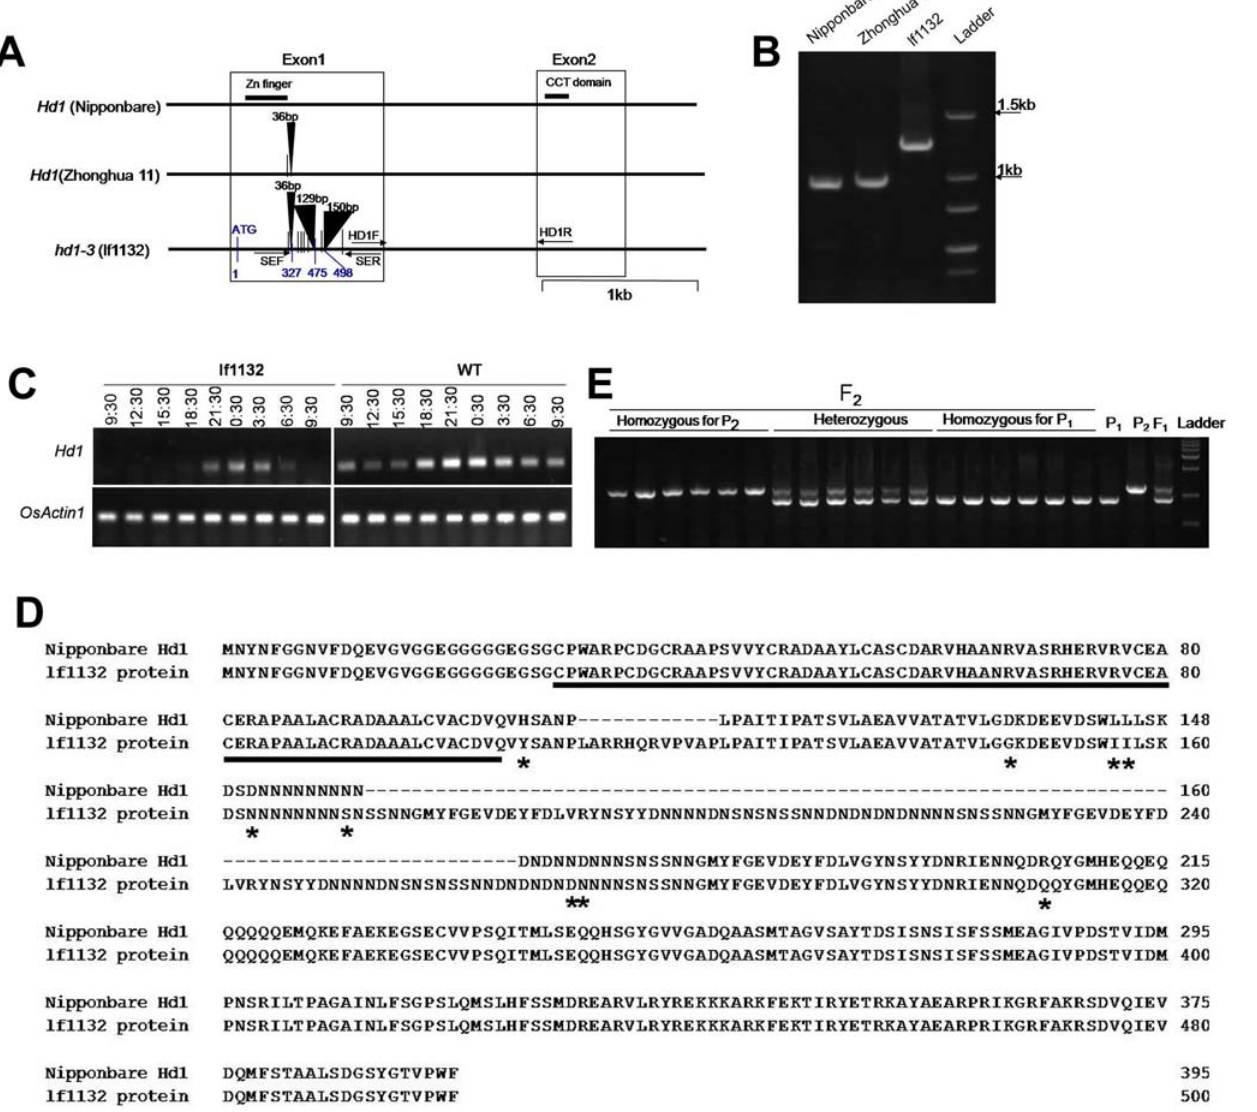
Figure 3. Sequence analysis of Hd1 in lf1132 and wild type. A: The sequence differences between wild type and lf1132 . The black triangle represents insertion; vertical lines represent single-base substitutions; blue vertical lines and numbers are relative positions in hd1-3 . SEF and SER shown by arrows are primers to detect the 315 bp insertion. B: PCR detection of the 315 bp insertion on the hd1-3 locus for lf1132 . C: The expression of Hd1 in the wild type and mutant. Leaves were harvested from 30 day old seedlings at the indicated times (once every 3 h for 24 h) in natural fields (day-length is about 14 h light and 10 h dark) and RT-PCR was carried out for the analysis of Hd1 expression. Primer pairs HD1F and HD1R were used for the analysis of Hd1 expression in RT-PCR. D: Deduced amino acid sequence of the Hd1 and deduced lf1132 proteins. The black line indicates the zinc-finger domain; asterisks are amino acid substitutions between the Nipponbare Hd1 protein and the deduced lf1132 protein. E: the linkage analysis of the mutant and Hd1 locus. P 1 is Zhonghua 11; P 2 is lf1132